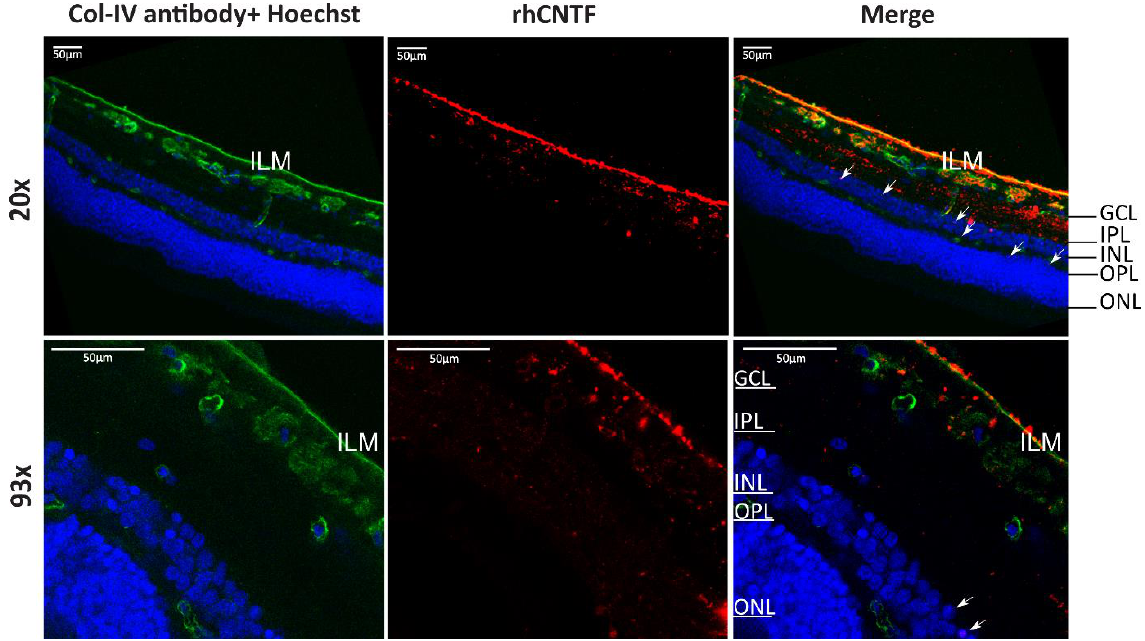
Figure 14. rhCNTF co-localizes with microglia in the ganglion cell layer. Fluorescence from Alexa Fluor™ 488 labeled rhCNTF (green) co-localizes with Iba-1 immunopositivity (red). GCL, ganglion cell layer; INL, inner nuclear layer.